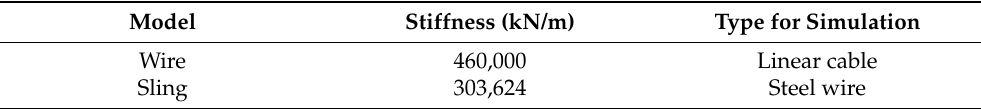
Table 4. Main parameters of the wire and the sling.